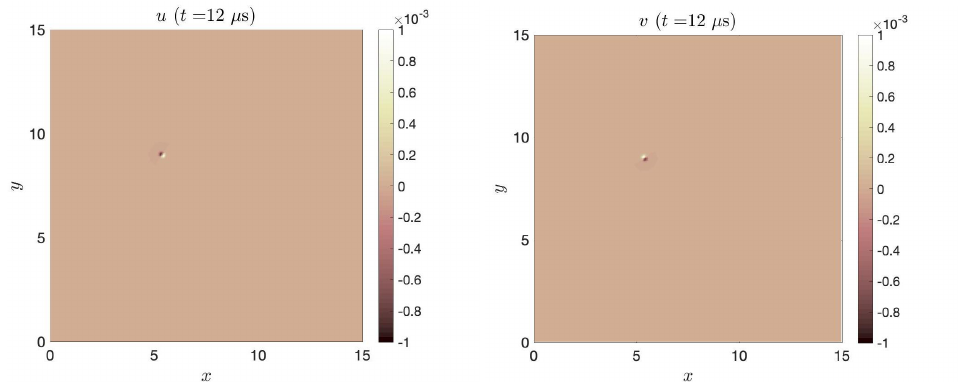
Figure 2. Components of the displacement vector ( u , v ) at time t 0 = 12 µs of crack